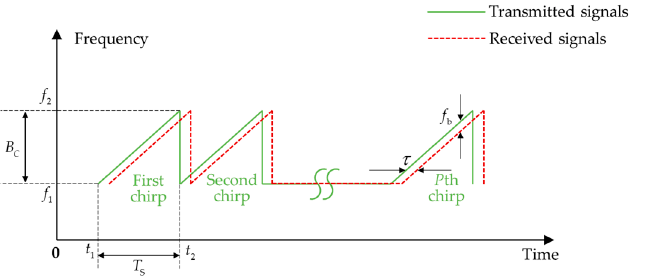
Figure 9. The transmitted and received chirp signals ( T s is the scanning period of one chirp which is the difference between t 1 and t 2 , B c is the scanning bandwidth which is the difference between f 1 and f 2 , τ is time delay of received signals compared to transmitted signals and f b is the difference frequency between the transmitted signals and received